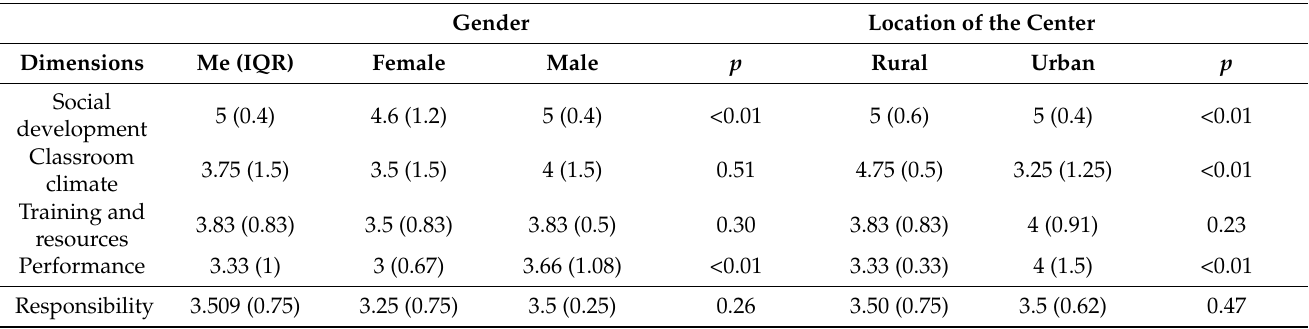
Table 3. Descriptive analysis of each dimension of the questionnaire.